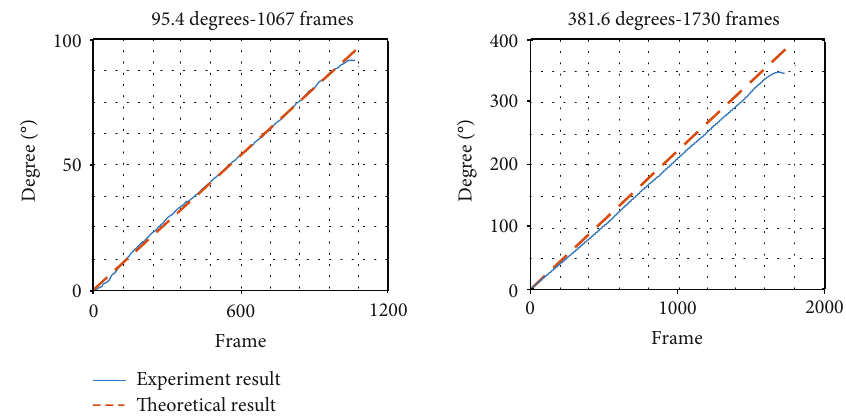
Figure 15: Angle estimation results of satellite model in experiments. Table 3: Comparison of theoretical results and calculated results. Theoretical value ( °